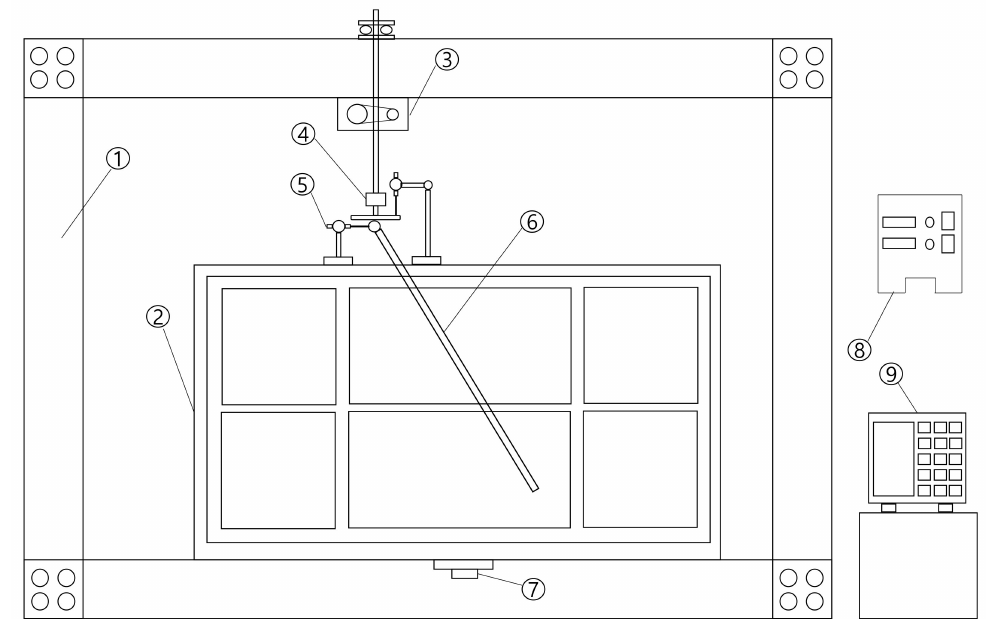
Figure 1. Schematic diagram of test setup [ 1 (cid:13) Steel frame, 2 (cid:13) Steel chamber (500 mm × 1400 mm × 1000 mm), 3 (cid:13) Load adding device, 4 (cid:13) Compression load cell, 5 (cid:13) Displacement gauge, 6 (cid:13) Model pile,